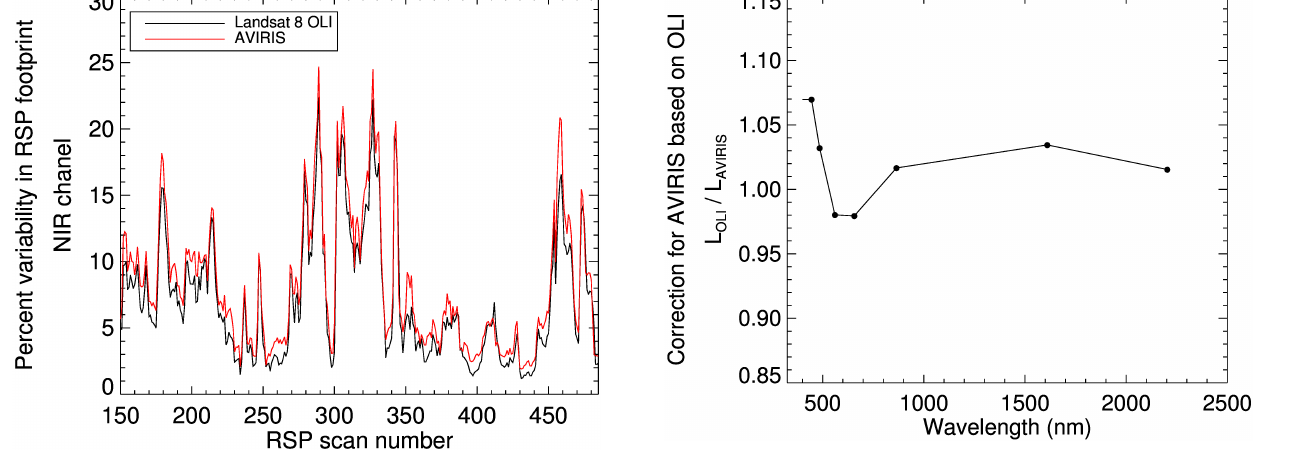
Figure 7. The percent standard deviation of each measurement along the flight path. There about 100 AVIRIS and OLI pixels within each RSP measurement footprint, and the variability of these pixels provides an assessment of the land surface uniformity within the RSP footprint. Measurements with high variability will be more sensitive to geolocation errors among the sensors and can be screened from further processing.